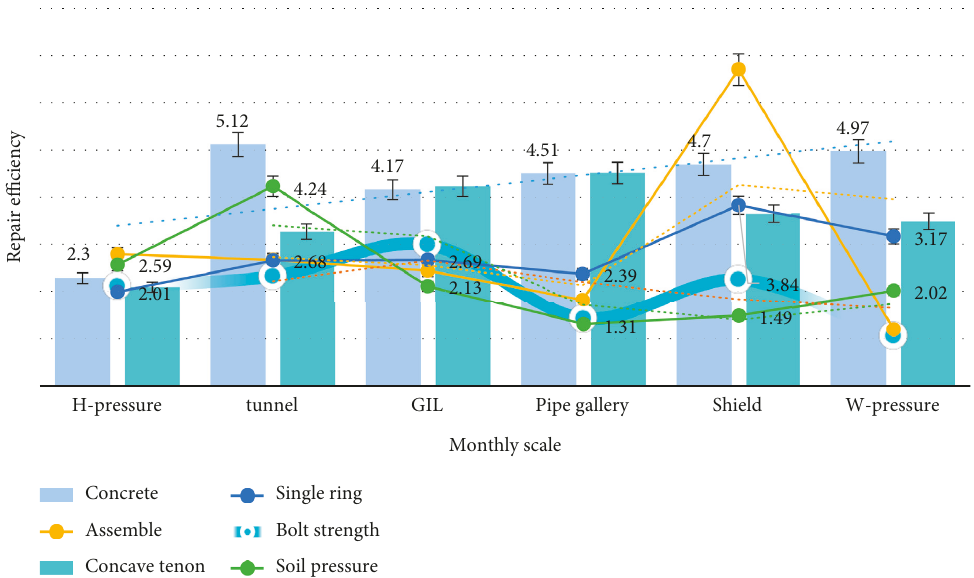
Figure 5: The occurrence and development of microcracks on the outer arc